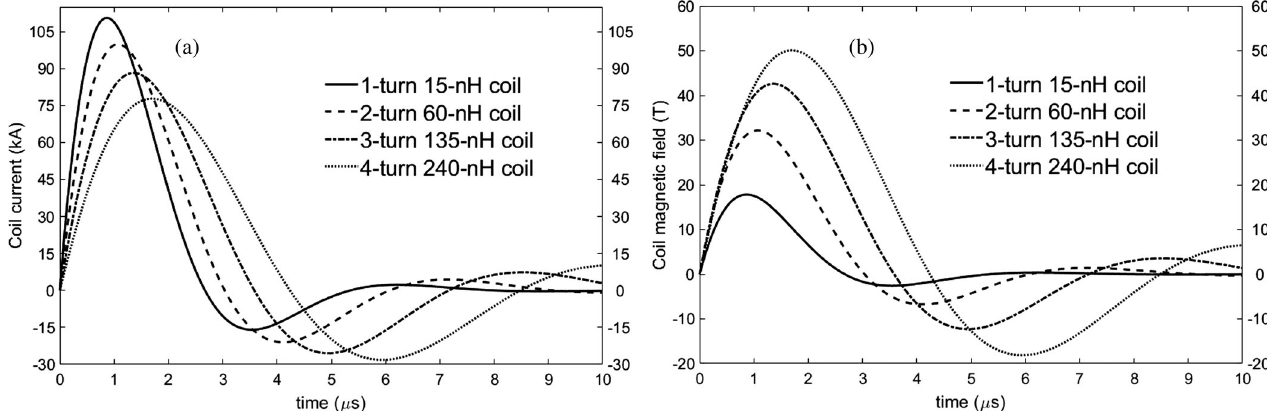
FIG. 7. MIFEDS-3 simulations into 1-, 2-, 3- and 4-turn coils. All coils have the same 7.8-mm average coil diameter. The left plot shows the S CREAMER current waveform simulations, and the right plot shows the corresponding coil magnetic field waveforms.